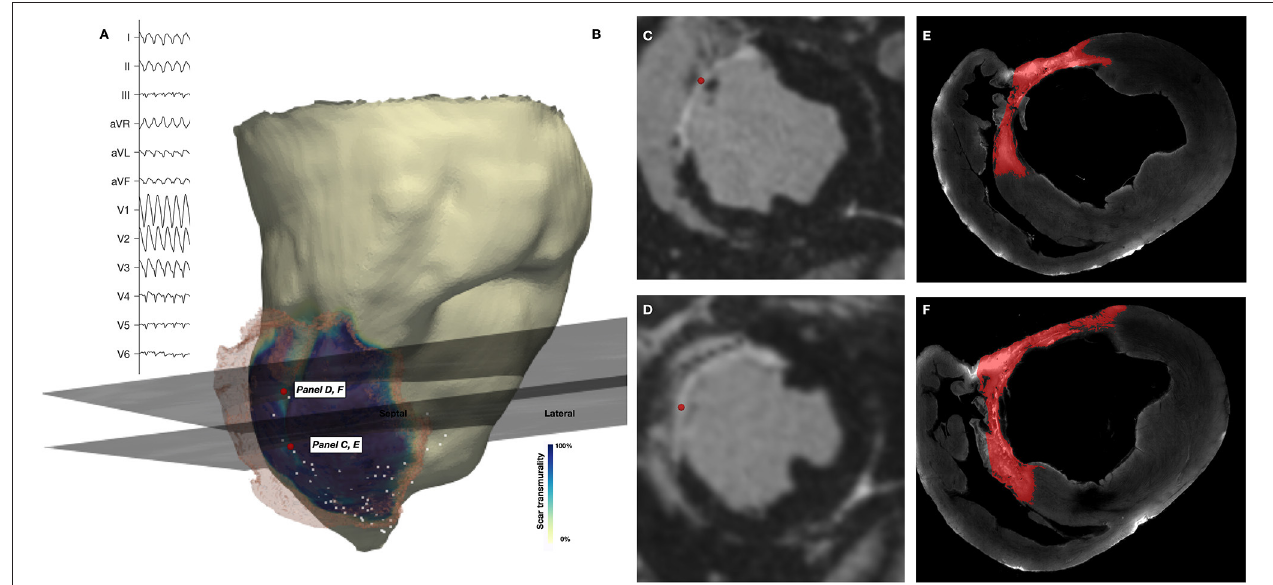
FIGURE 3 | Co-localization of diastolic locations from Electroanatomic Mapping System and in-vivo imaging and episcopic auto-fluorescence cryomicrotome imaging. (A) Surface 12-lead ECG of induced VT. (B) In-vivo CMR derived shell color coded according to scar transmurality, with translucent mesh derived from scar also shown. Location of 2 diastolic EGMs is shown (red spheres) and corresponding short axis (SAX) in-vivo LGE CMR slice. (C,D) SAX slices shown in (B) , with location of recorded EGM (red sphere). (E,F) Corresponding EACI data with segmented scar (red)